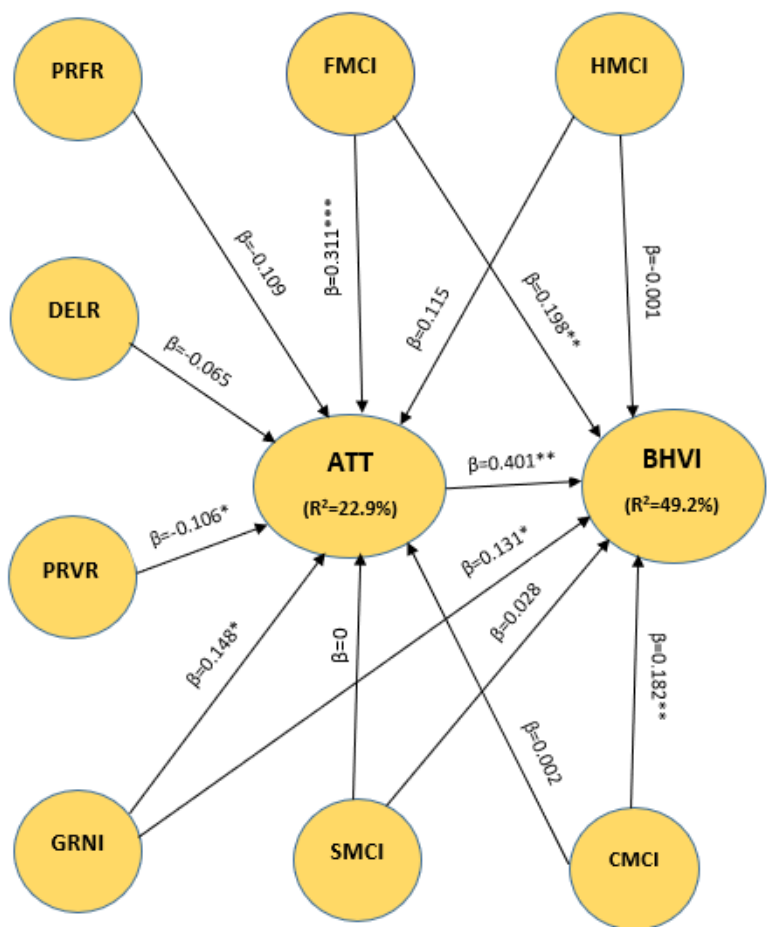
Figure 2. Partial least square results. fMCI = functionally motivated consumer innovativeness; hMCI = hedonically motivated consumer innovativeness; cMCI = cognitively motivated consumer innovativeness; sMCI = socially motivated consumer innovativeness; GRNI = green image; PRFR = performance risk; DLVR = delivery risk; PRVR = privacy risk; ATTD = attitude; BHVI = behavioral intention. *** p < 0.001, ** p < 0.01, * p < 0.1.